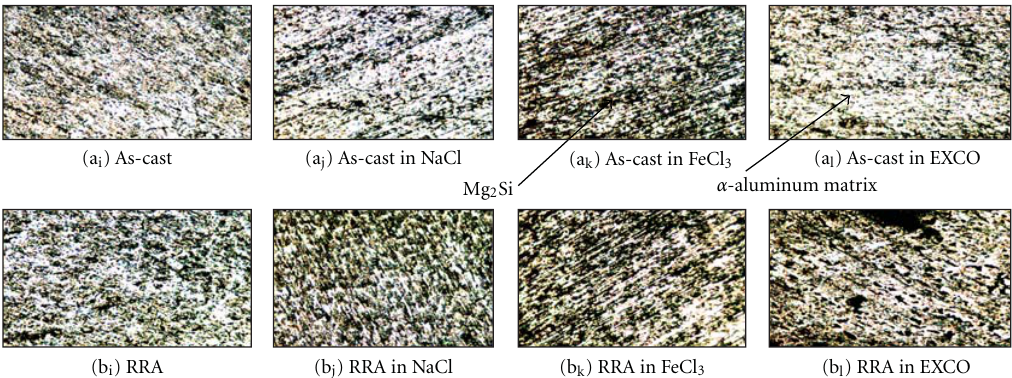
Figure 7: Micrographs of 0.91% Mg addition for untreated (a i –a l ) and treated (b i –b l )